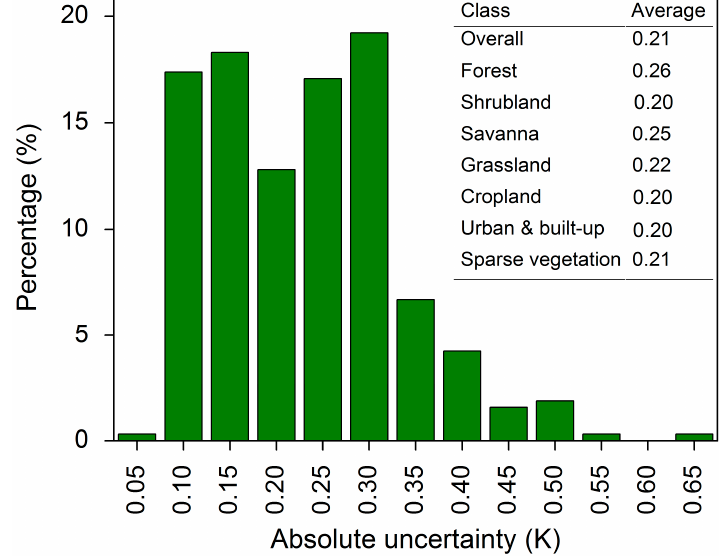
Figure 11. Frequency of the absolute uncertainty over weather stations and the statistics of the absolute uncertainty by land cover.